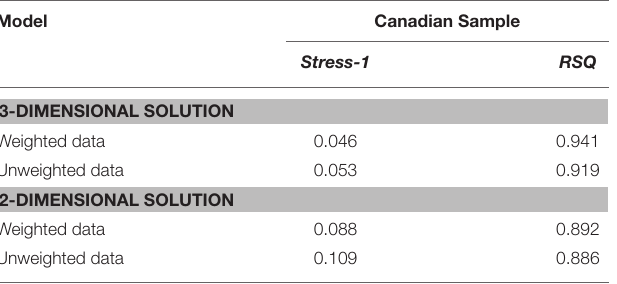
TABLE 3 | Model Fit Results for Study 2 with the Canadian sample using Classical MDS (C-MDS) with and without weighted data derived from cultural consensus analysis (see text for details).